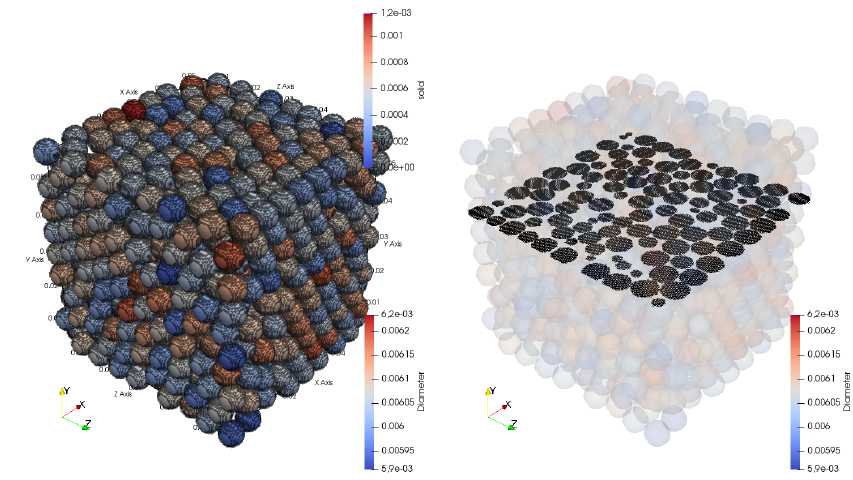
Figure 10. Virtual bed sample number 3 in resolution 150 × 150 ×